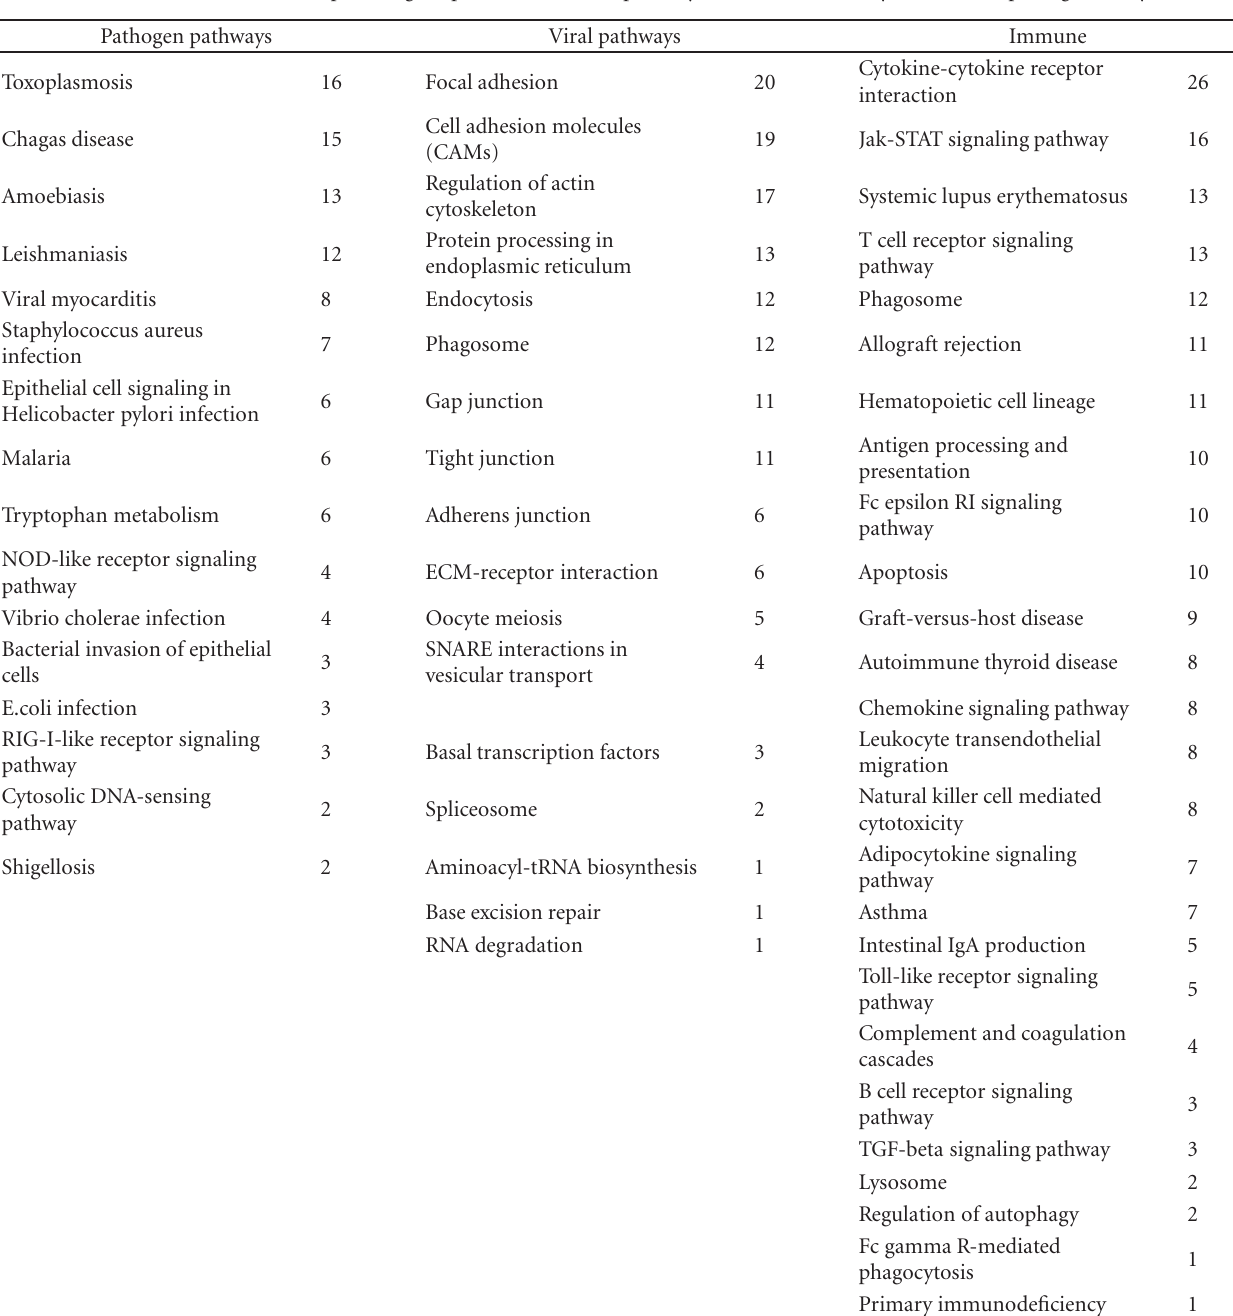
Table 5: The number of schizophrenia gene products in KEGG pathways related to immunity, and viral or pathogen life cycles. Pathogen